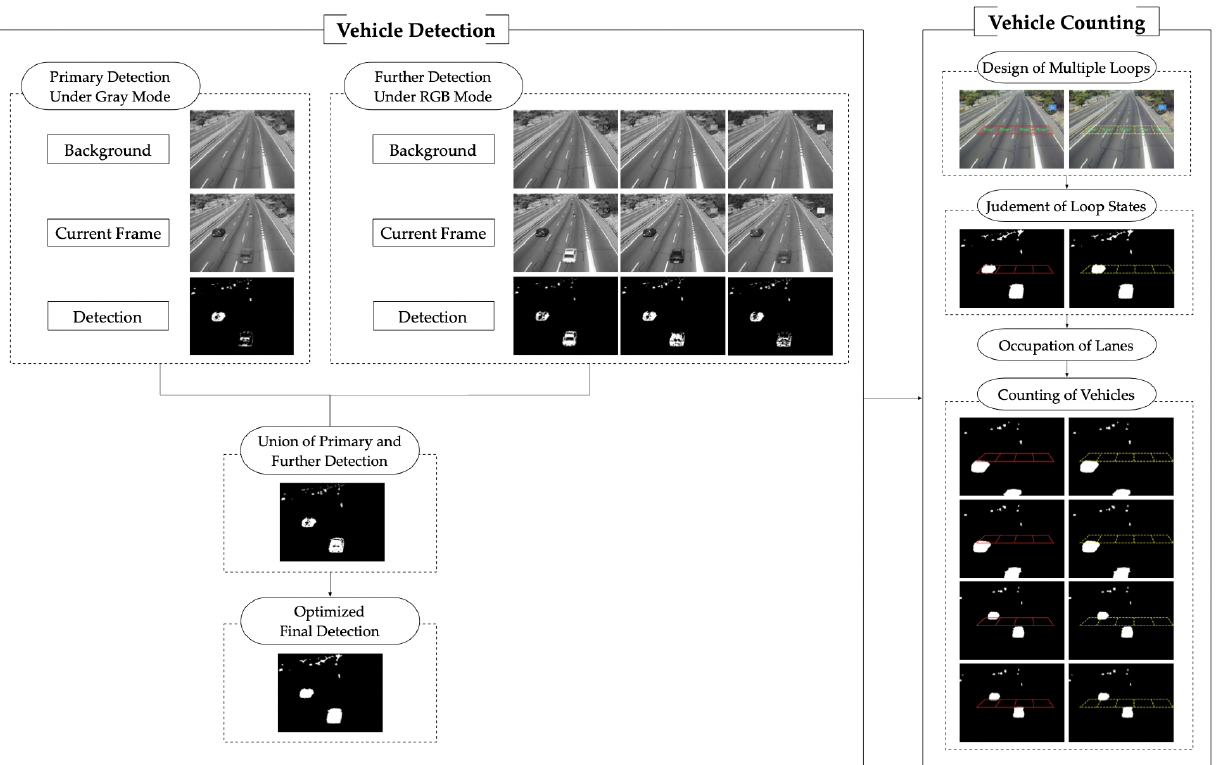
Figure 1. Block diagram of the proposed